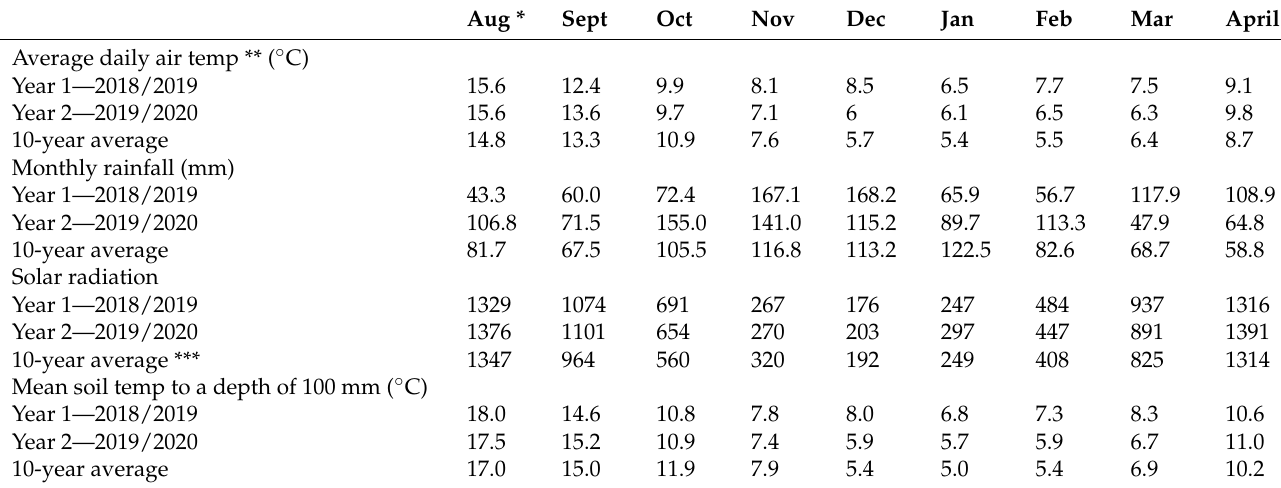
Table 1. Average daily air temperature ( ◦ C), monthly rainfall (mm), solar radiation, and mean soil temperature to a depth of 100 mm ( ◦ C) between August and April for Year 1 (2018/2019), Year 2 (2019/2020) and the 10-year average (2006–2016) at the experimental site.